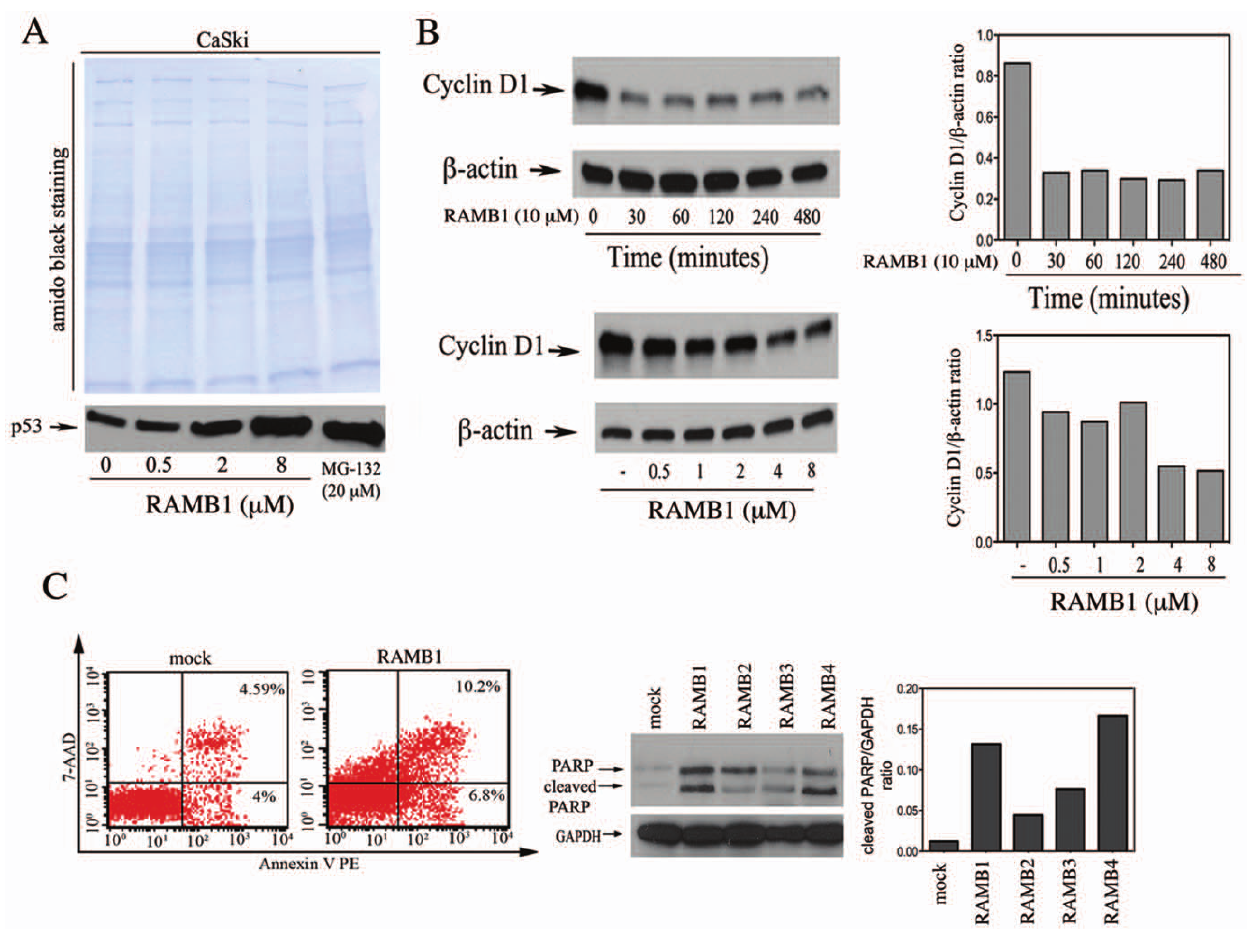
Figure 7. Stabilization of p53, reduction in cyclin D1 and onset of apoptosis following RAMB1 treatment. A. Immunoblot analysis of p53 expression level in CaSki cells treated with the indicated concentration of RAMB1 over a period of 8 hours. Equal loading is each lane was verified by amido black staining. B. Top left panel: Immunoblot analysis of cyclin D1 expression level in CaSki cells with or without 10 m M RAMB1 for a period up to 8 hours. Protein loading was examined using an antibody against b -actin. Top right panel: Quantification of the cyclin D1/ b -actin ratio. Bottom left panel: Immunoblot analysis of cyclin D1 expression level in CaSki cells with or without RAMB1, at the indicated concentration for a period of 8 hours. Equal protein loading in each lane was verified by using an antibody against b -actin. Bottom right panel: Quantification of the cyclin D1/ b - actin ratio. C. Left panel . HeLa cells were treated with 10 m M of RAMB1 for 8 hours and analyzed by flow cytometry after staining for annexin V binding and 7-AAD incorporation. Middle panel : Immunoblot analysis of full length and cleaved PARP in HeLa cells treated 10 m M of RAMBs over a period of 8 hours. Protein loading was assessed using an antibody against b -actin. Right panel : Quantification of cleaved PARP/ b -actin ratio.